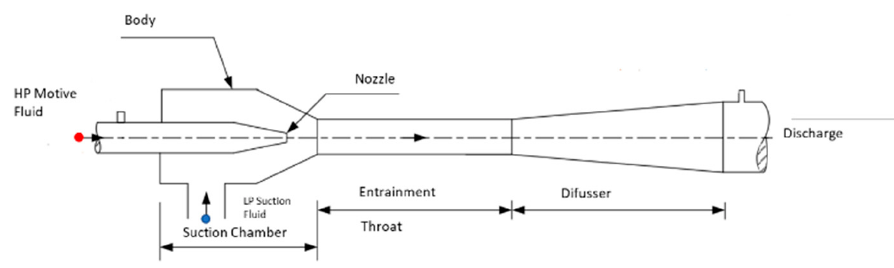
Figure 4. Jet pump diagram